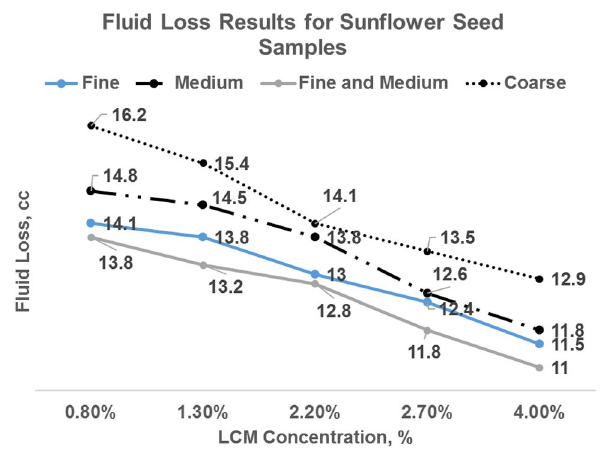
Fig. 8 Fluid loss results for sunflower seed samples